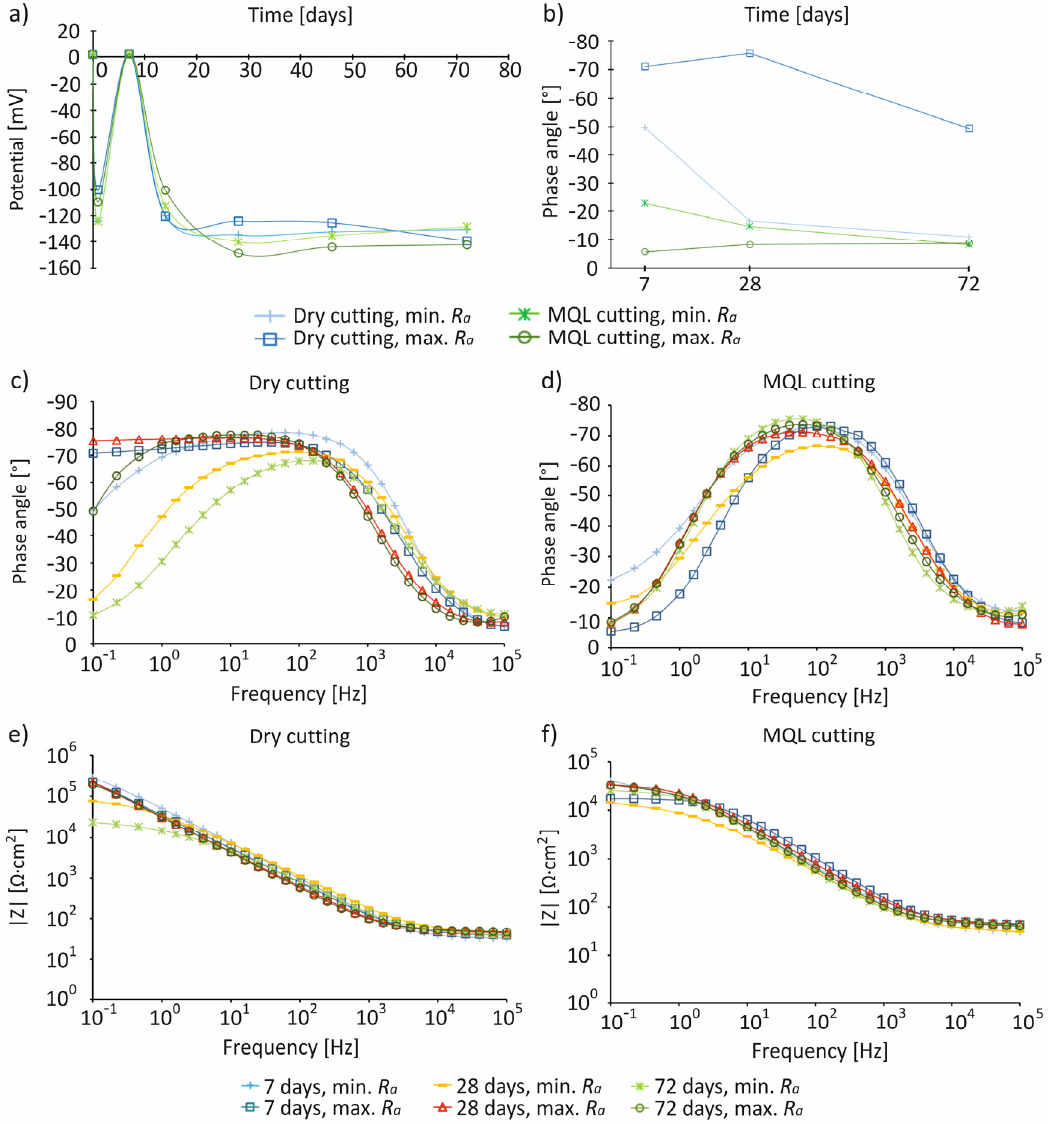
Figure 6. The results of electrochemical tests of Ti6Al4V alloy samples after turning under dry and MQL conditions with R a min and R a max stored in SBF: changes in corrosion potential for 72 days ( a ) the value of the phase angle at the frequency of 0.1 Hz after 7 days ( b ) the Bode phase plots after 7, 28, and 72 days ( c , d ) and the Bode plots after 7, 28, and 72 days ( e , f ).